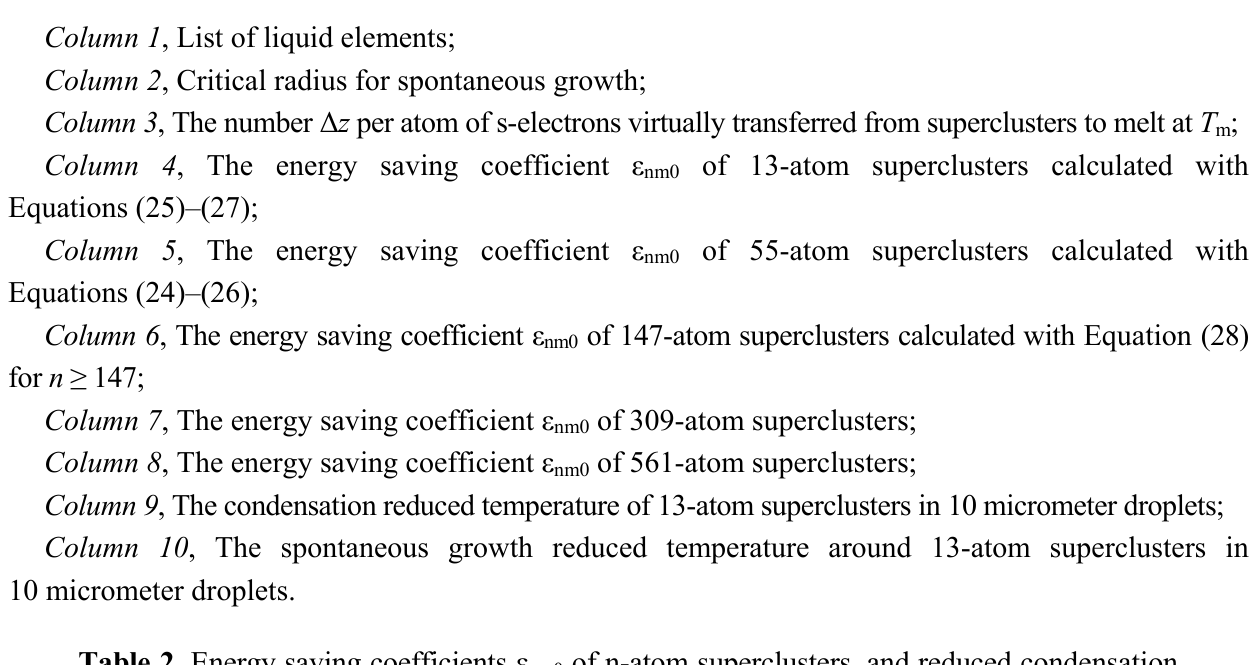
of n-atom superclusters, and reduced condensation nm0